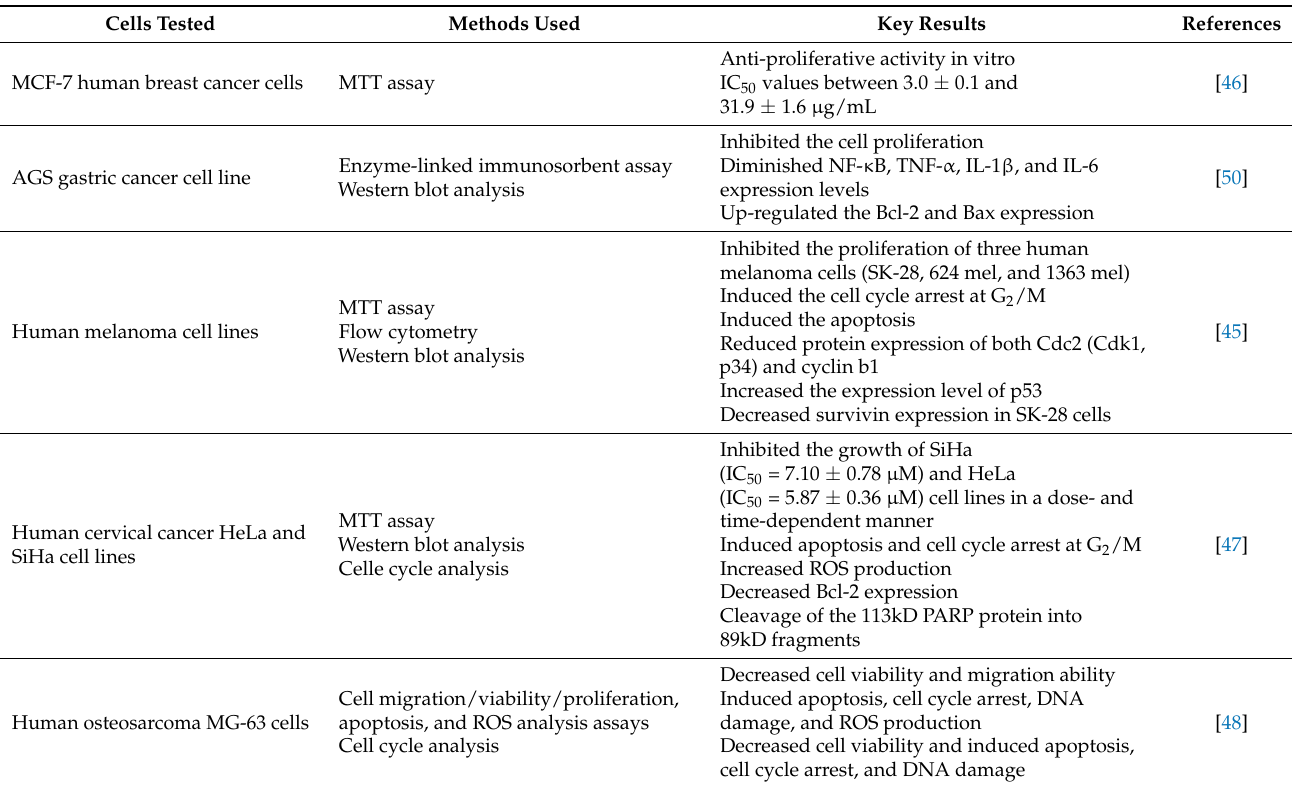
Table 2. Anticancer effect of